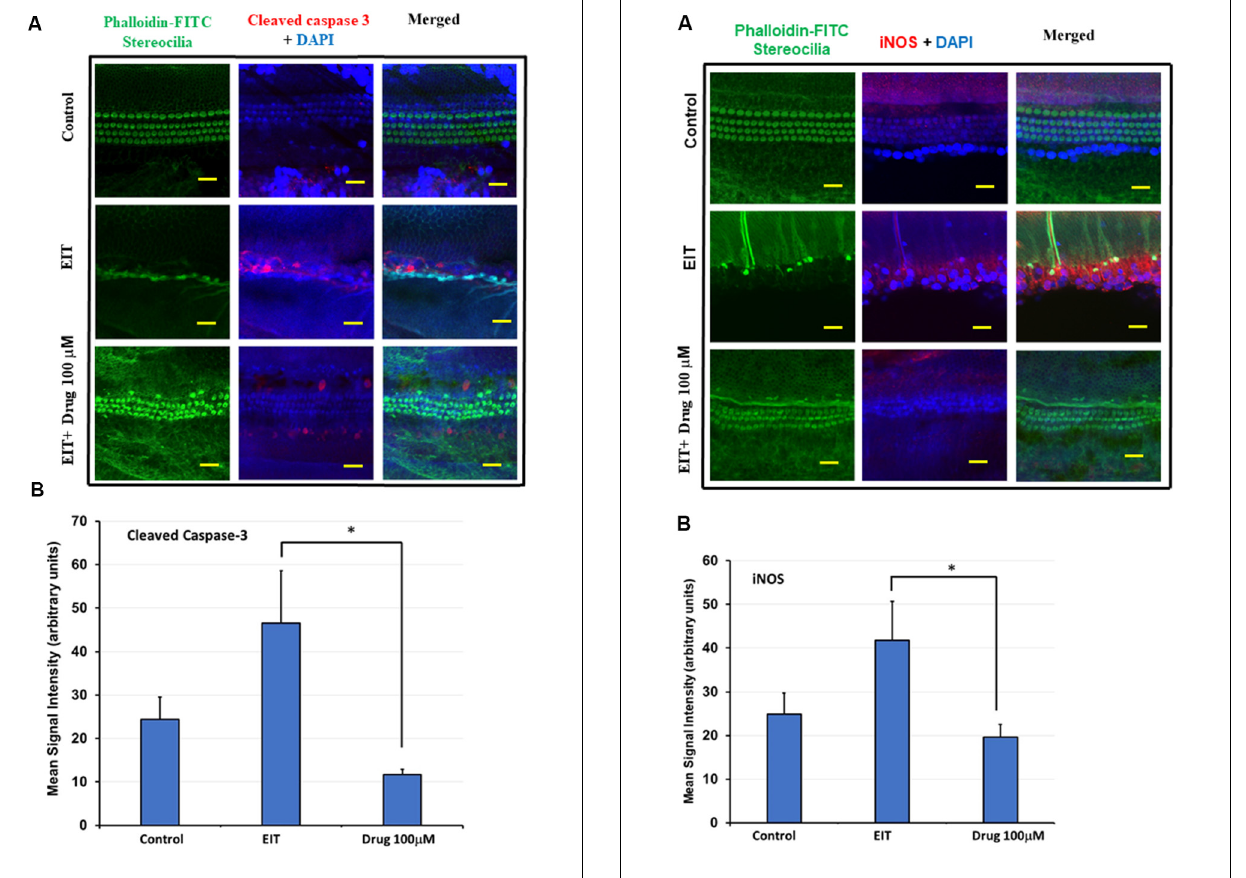
FIGURE 4 | Cleaved caspase 3 immunostaining of OC explants treated with TDCA. (A) OC explants were subjected to cleaved caspase 3 immunostaining to determine apoptosis. The first column shows the explant’s stereocilia bundles stained with FITC-phalloidin. Cell nuclei were stained with DAPI (blue color). (B) Mean signal intensity for cleaved caspase 3 immunostaining was calculated using ImageJ software. Data are expressed as mean values ± SD and is representative of three independent experiments. ∗ P < 0.001 compared to the EIT group. n = 6 OCs per group. Scale bars: 10 µ m.